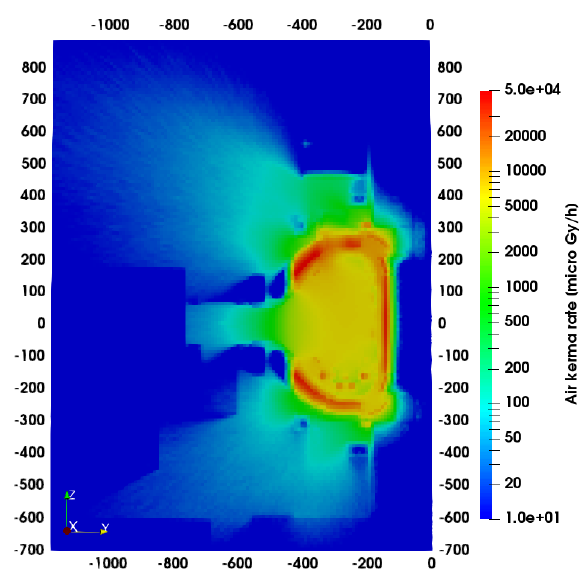
Figure 5: Air kerma rate in Octant 1 6 h after shut down.